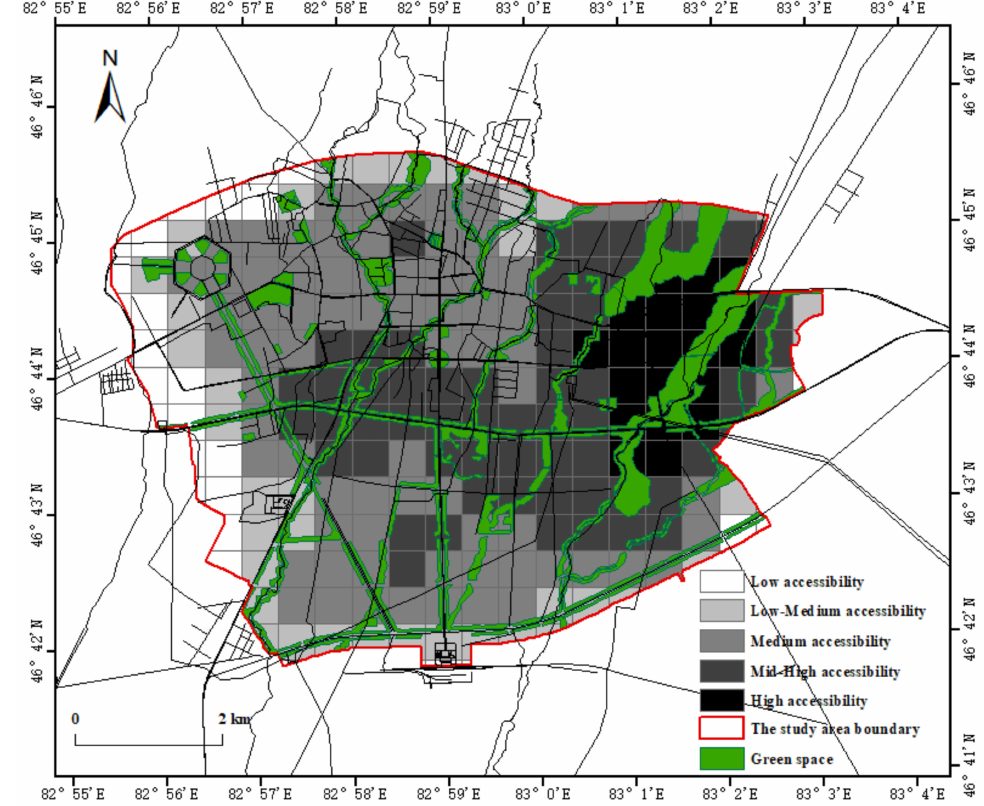
Figure 4. Green space accessibility analysis chart.